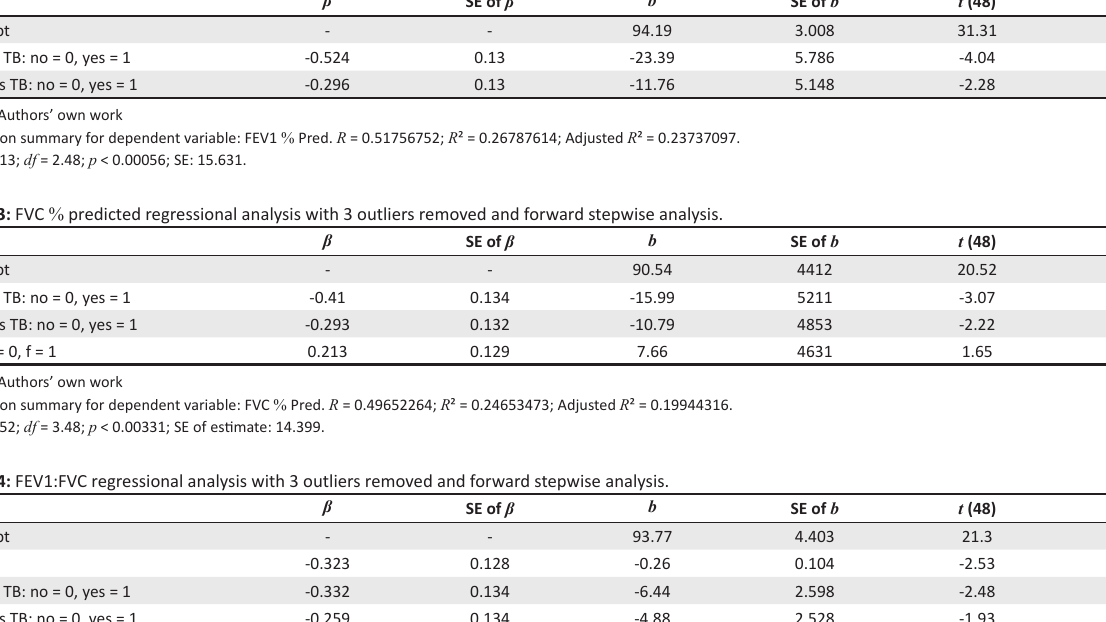
TABLE 2: FEV1 % predicted regressional analysis with 4 outliers removed and forward stepwise analysis. N = 51 β SE of β